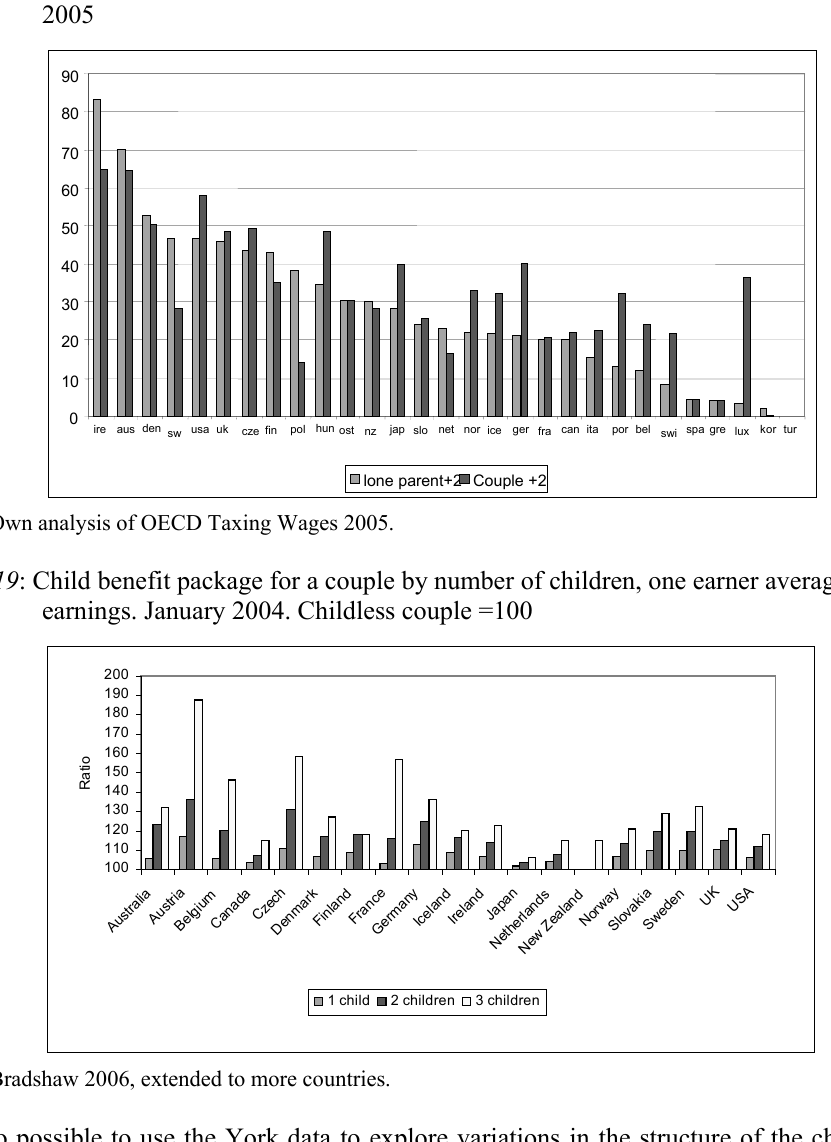
Figure 18 : Child benefit package at half average earnings, lone parents and couples with two children. Percentage more than a childless couple on the same earnings.